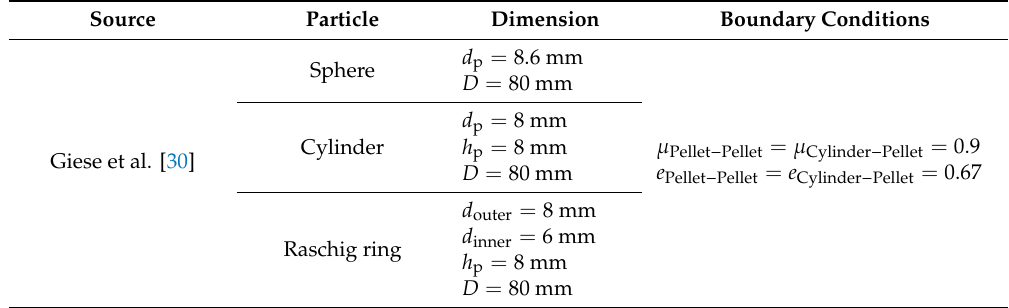
Table 4. Boundary conditions of all